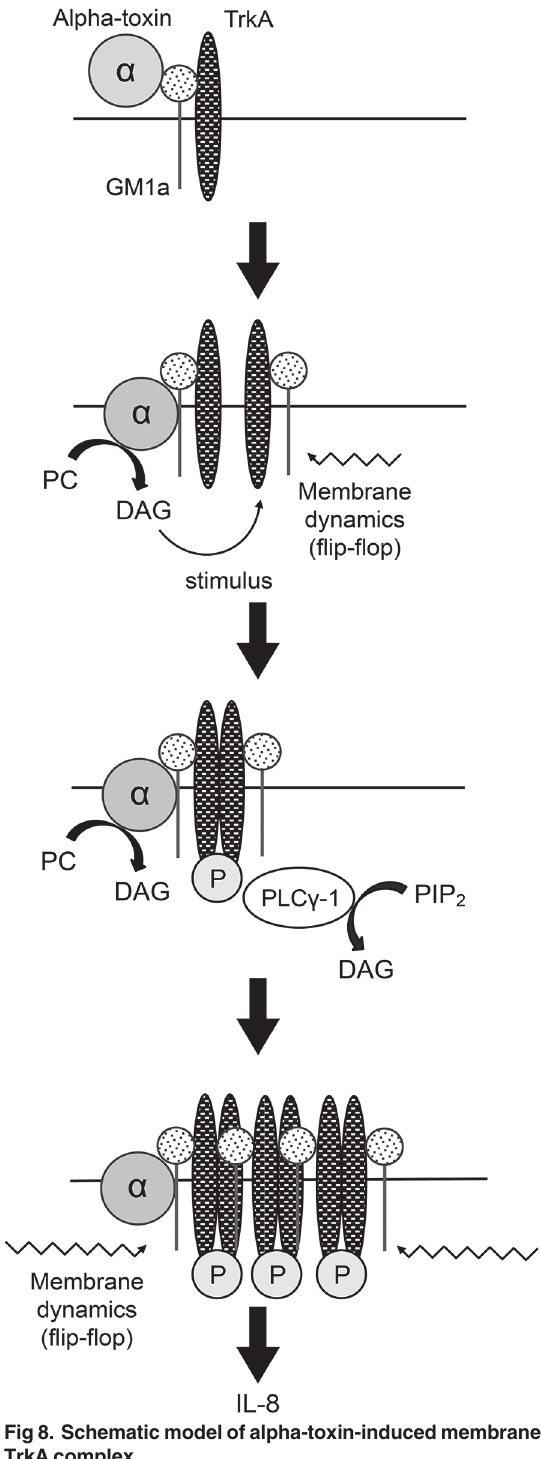
Fig 8. Schematic model of alpha-toxin-induced membrane dynamics and accumulation of the GM1a/ TrkA complex